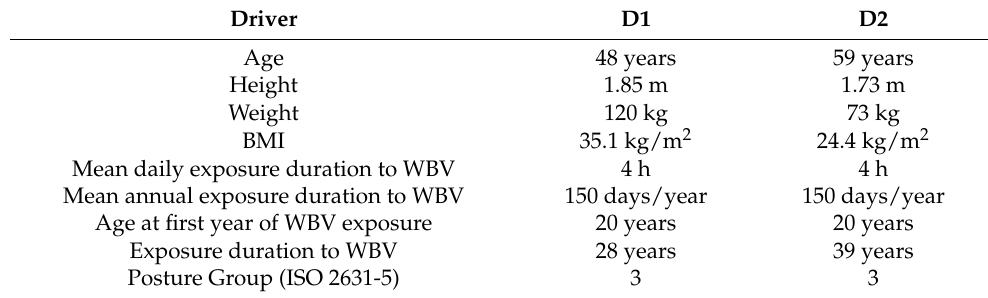
Table 1. Characteristics of drivers.